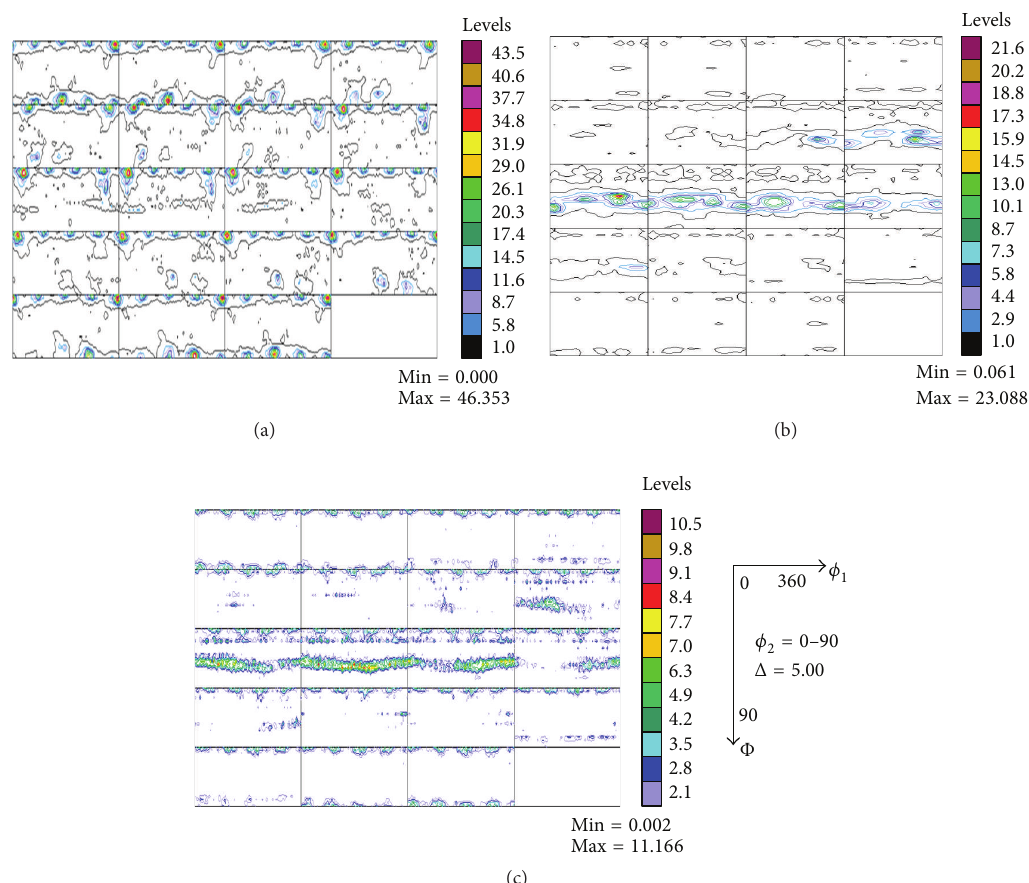
Figure 5: ODFs for constant 𝜙 2 value in range of 0–90 ∘ /5 ∘ for Ni ⟨100⟩ (a), ⟨110⟩ (b), and single crystals and polycrystal